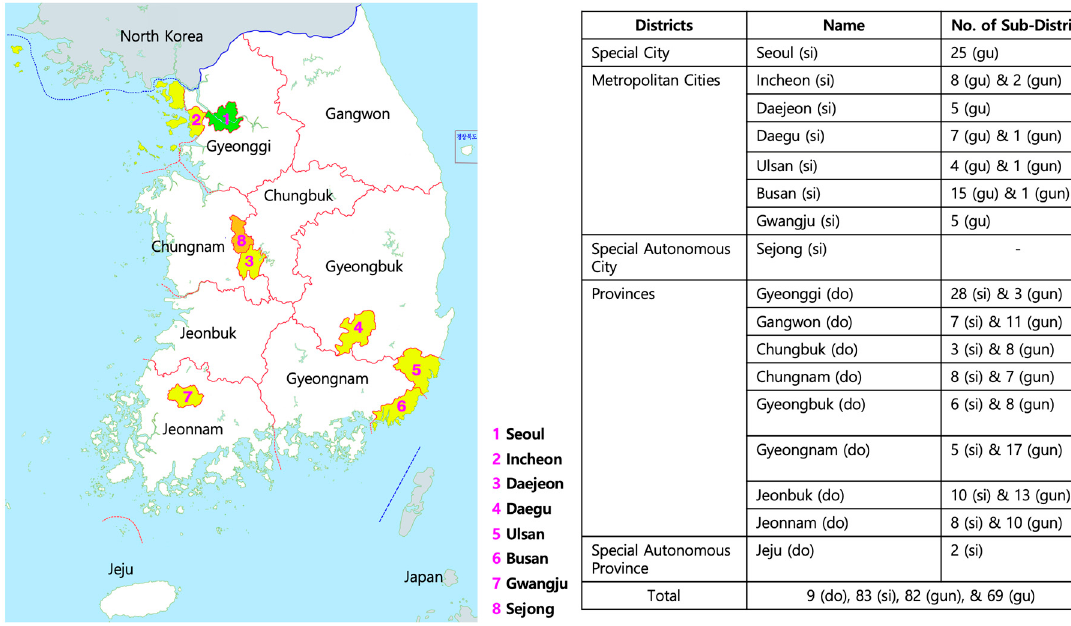
Figure 1. Administrative districts in South Korea.